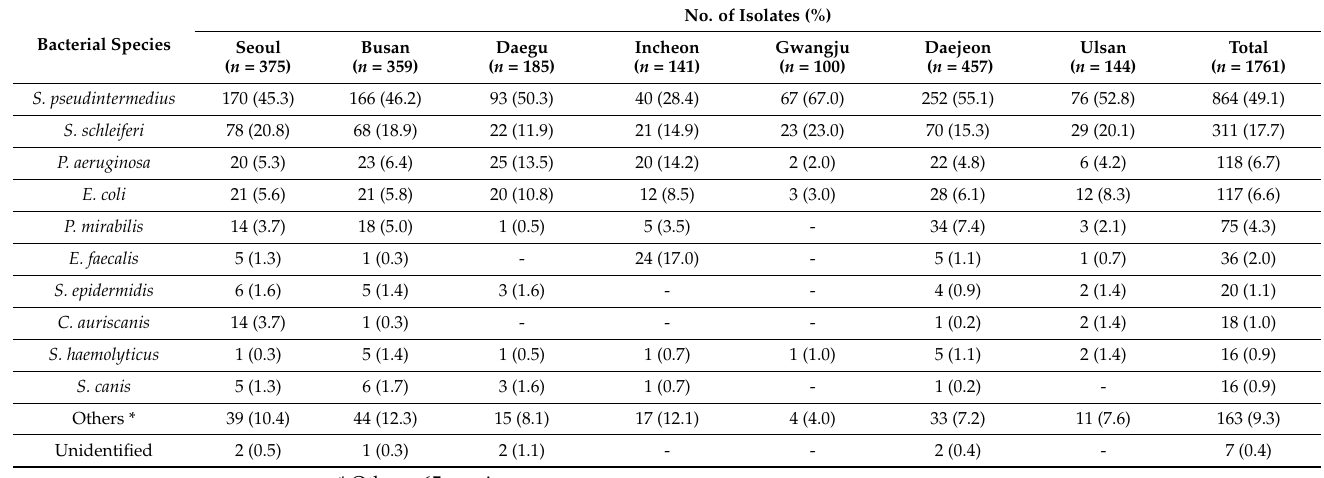
Table 3. Recovered isolate prevalence in skin samples of dogs during nationwide surveillance (2018–2019).